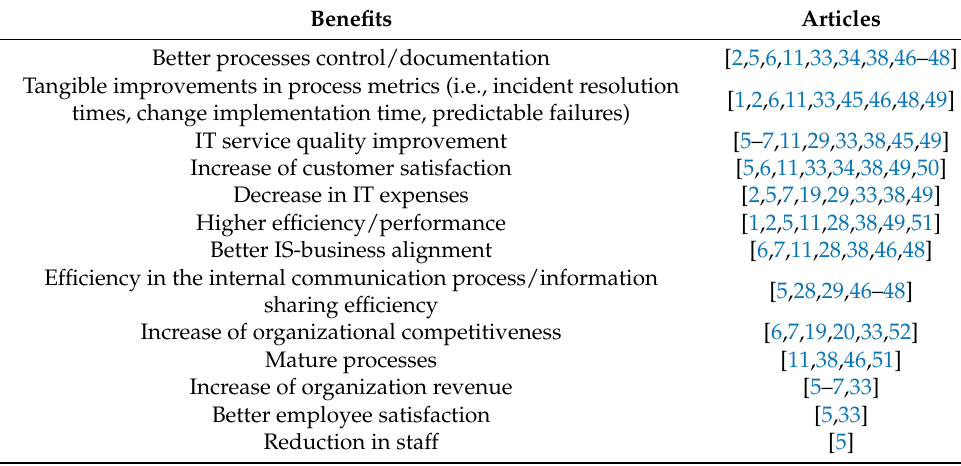
Table 2. ITSM Benefits. Benefits Articles Better processes control/documentation Tangible improvements in process metrics (i.e., incident resolution times, change implementation time, predictable